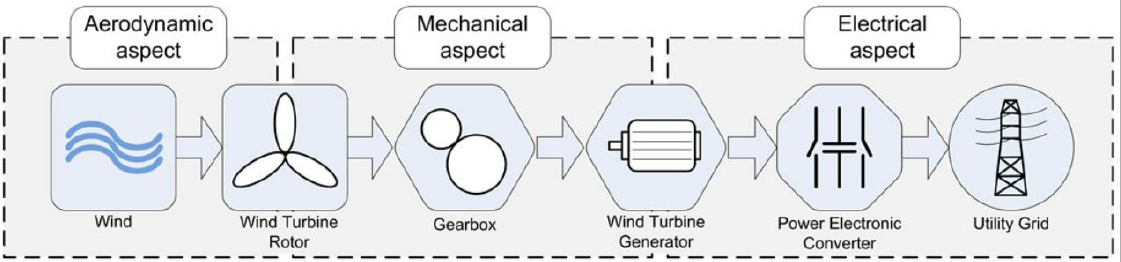
Figure 2. Major components of Wind system.